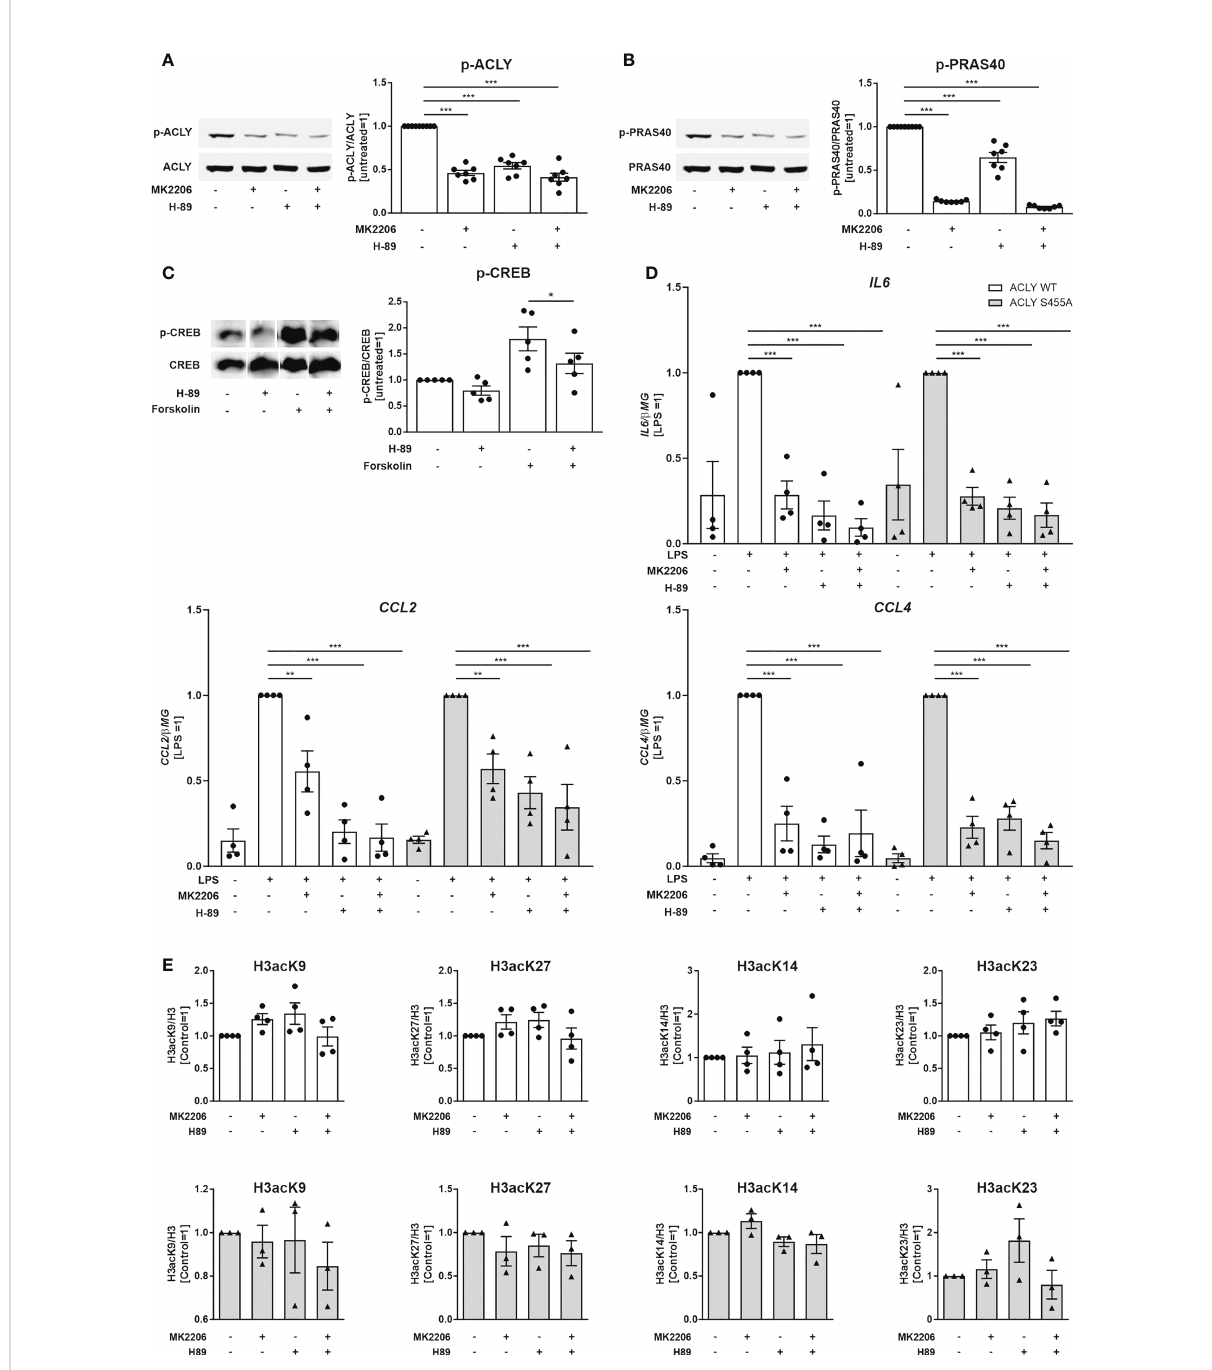
FIGURE 3 Effects of Akt and PKA inhibition on ACLY phosphorylation, LPS-induced pro-in fl ammatory cytokine production and basal histone acetylation in THP-1 cells. (A) Western blot analysis of ACLY phosphorylation in ACLY WT cells upon treatment with 10 m M MK2206 or 10 m M H-89 for 30 minutes. (B) Western blot analysis of PRAS40 phosphorylation in ACLY WT cells upon treatment with 10 m M MK2206 or 10 m M H-89 for 30 minutes. (C) Western blot analysis of CREB phosphorylation upon treatment with 10 m M H-89 or 50 m M forskolin for 30 minutes (D) mRNA expression of IL6, CCL2 and CCL4 in ACLY WT and S455A THP-1 cells following treatment with 10 m M MK2206 or 10 m M H-89 for 30 minutes and 100 ng/ml LPS for 3 hours. (E) Western blot analysis of histone H3 acetylation at K9, K27, K14 and K23 in ACLY WT and S455A cells after treatment with 10 m M MK2206 or 10 m M H-89 for 30 minutes. Data represent mean values ± SE of 3-7 independent experiments. * p<0.05, ** p<0.01, ***